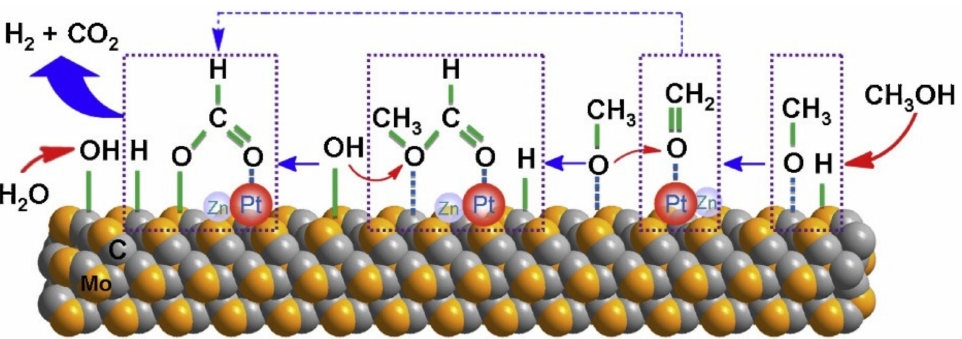
Figure 12. Proposed reaction pathway for methanol steam reforming performed on 0.5Zn-Pt/MoC catalyst. (Adapted from [138], copyright 2020,